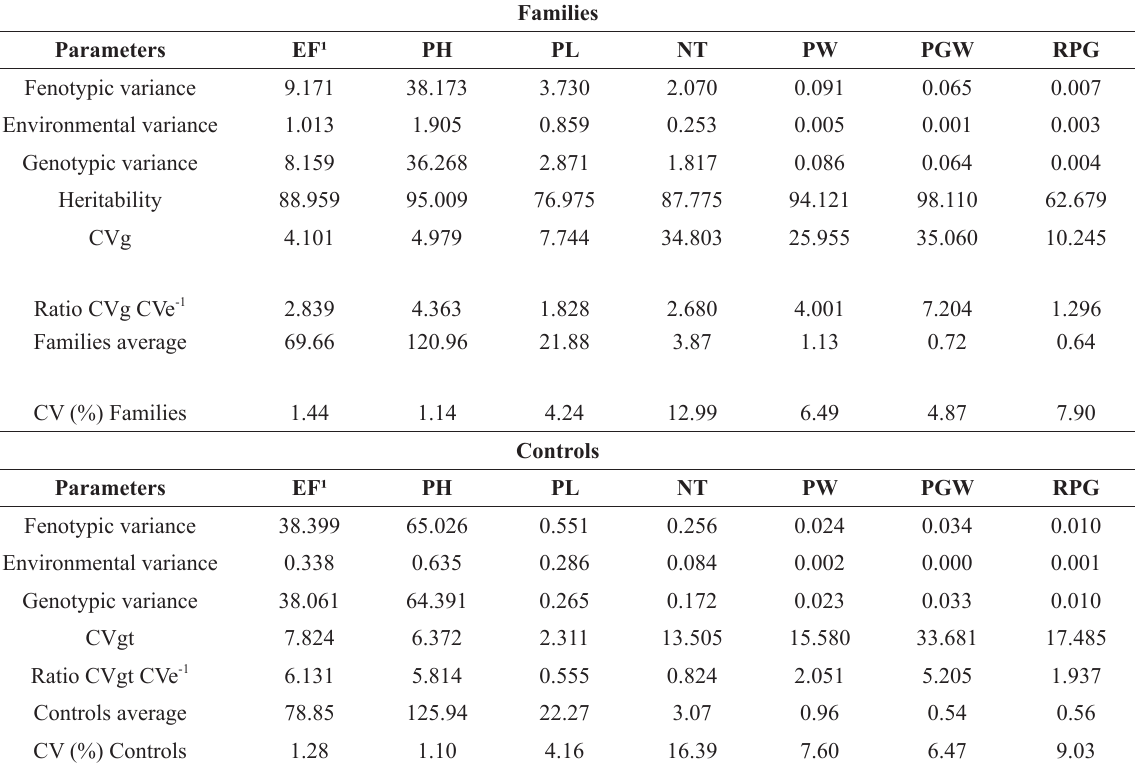
Variance components and genetic parameters estimated for families and controls for 2017 crop